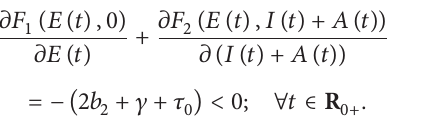
Figure 25: Evolution of the asymptomatic subpopulation with a daily culling rate of 𝜌 𝐷 = 0.1